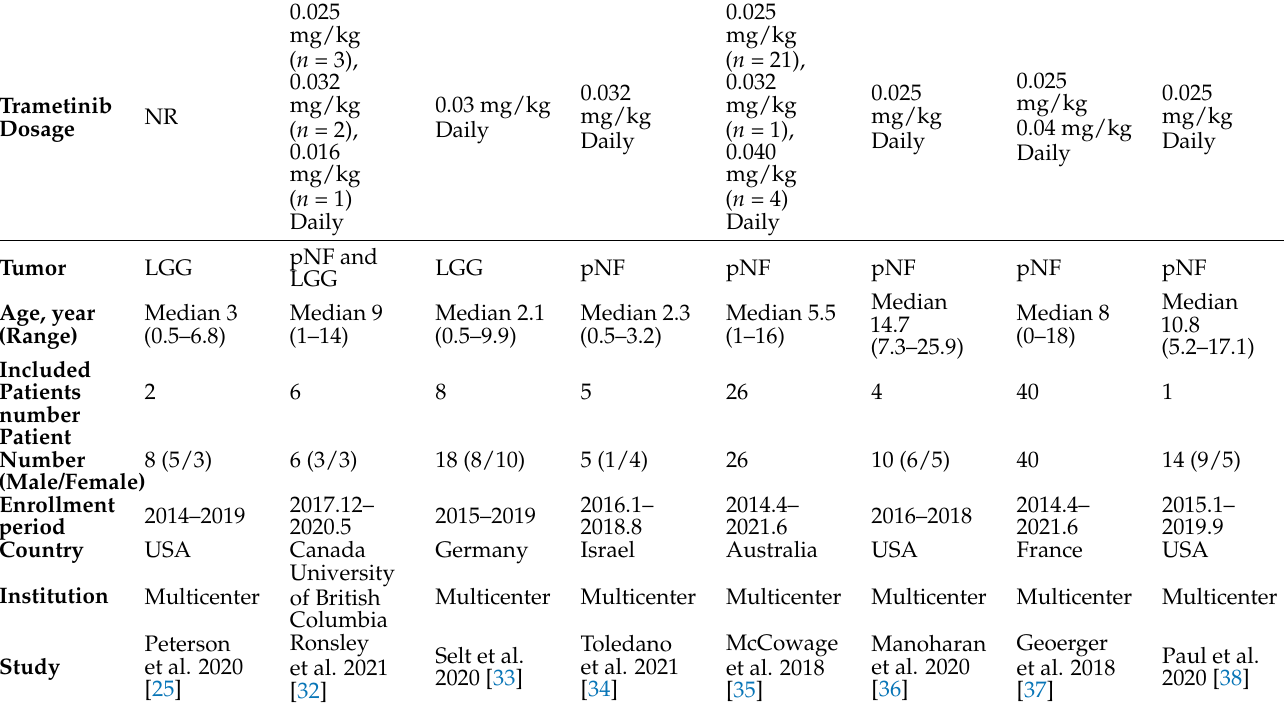
Figure 1. Flow chart showing the process of identification of selected studies. Table 1. Study and patient characteristics.